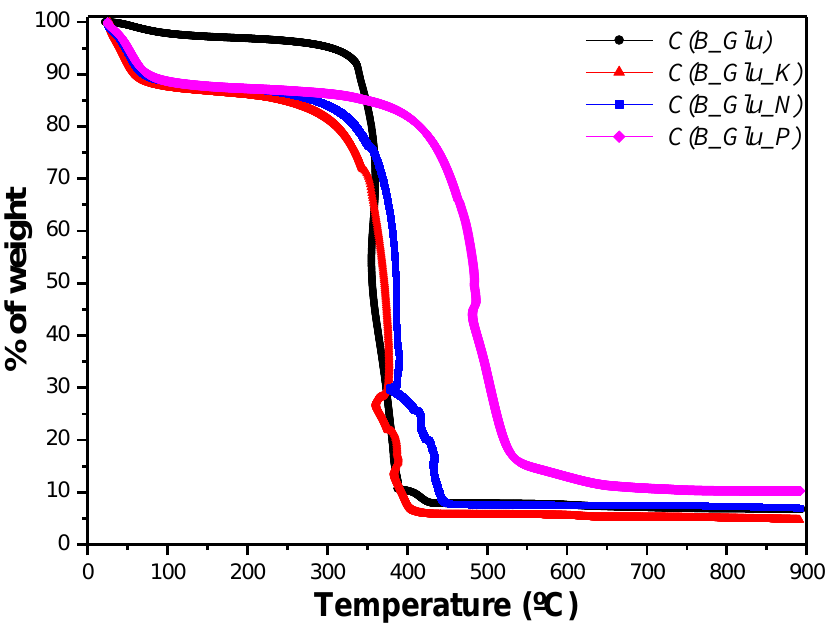
Figure 8. Thermal analysis for the obtained carbons. Taking into account the combustion temperature of the carbonaceous skeleton (Table